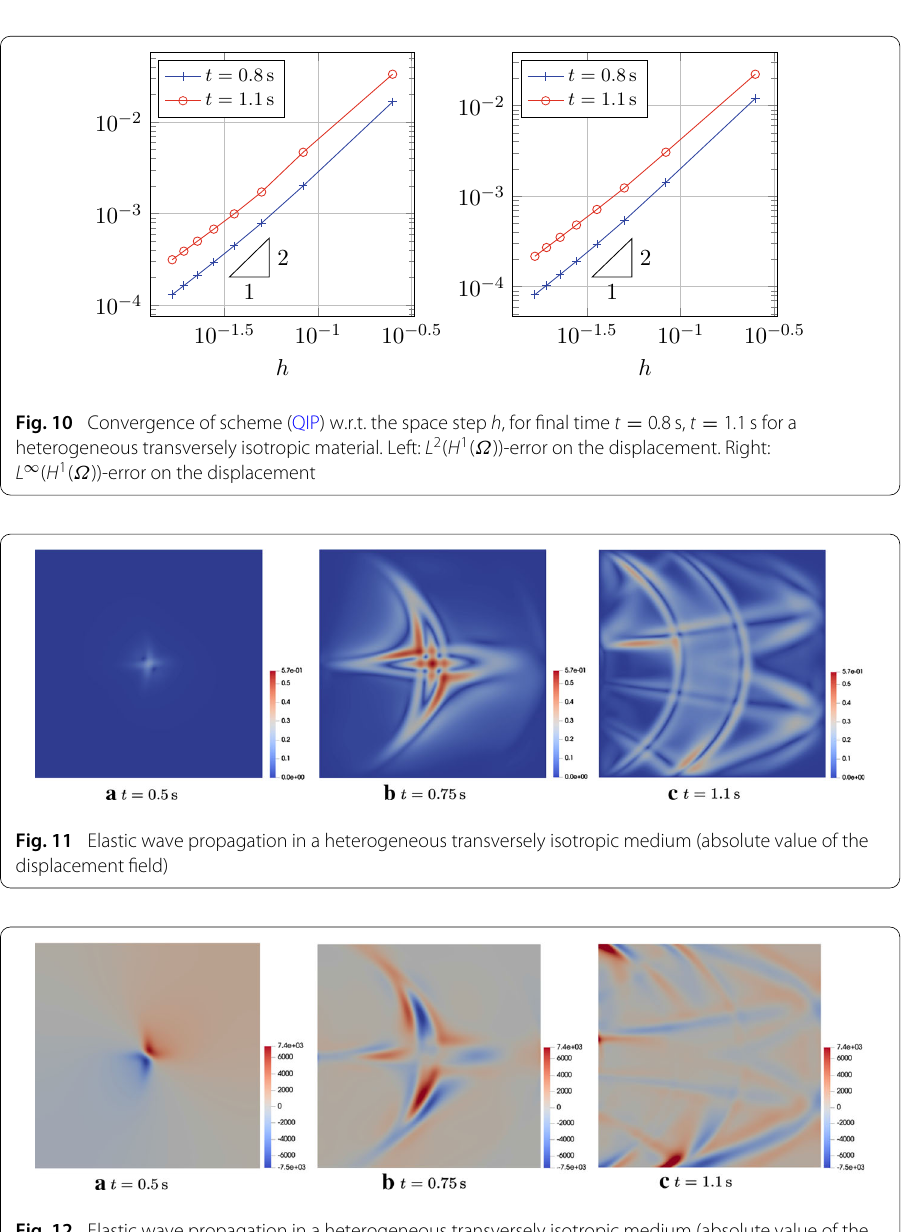
Fig. 12 Elastic wave propagation in a heterogeneous transversely isotropic medium (absolute value of the pressure